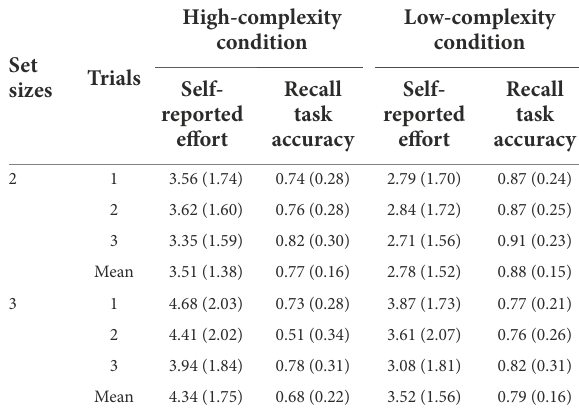
TABLE 3 Mean (SD) of the subjective measurement and performance measurement in memory tasks.